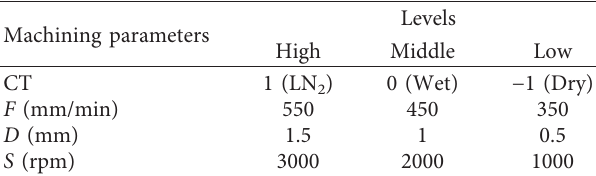
Table 2: The machining variables and